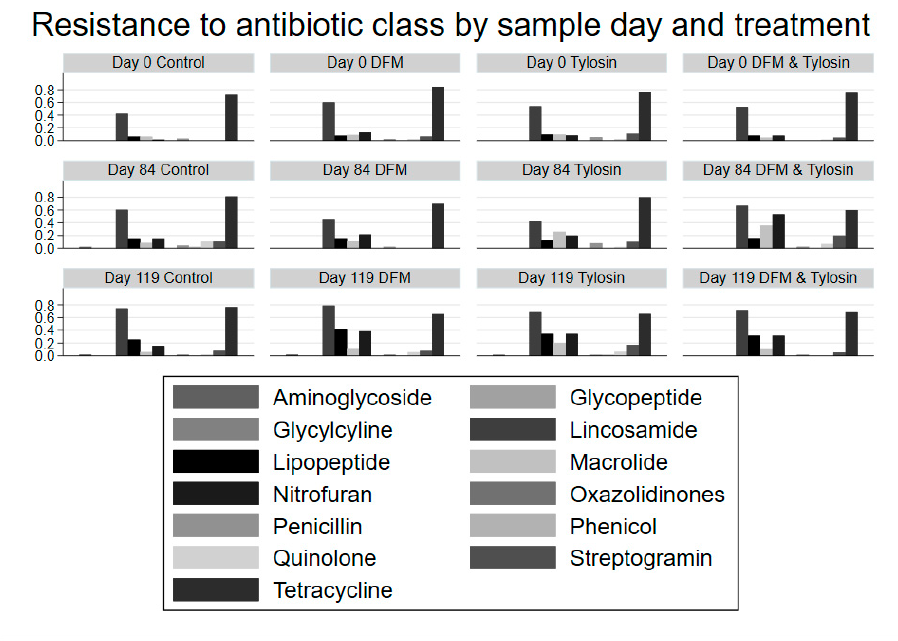
Figure 4. Resistance (proportion) of Enterococcus spp. isolates to each antibiotic class by sample day and treatment group. and treatment